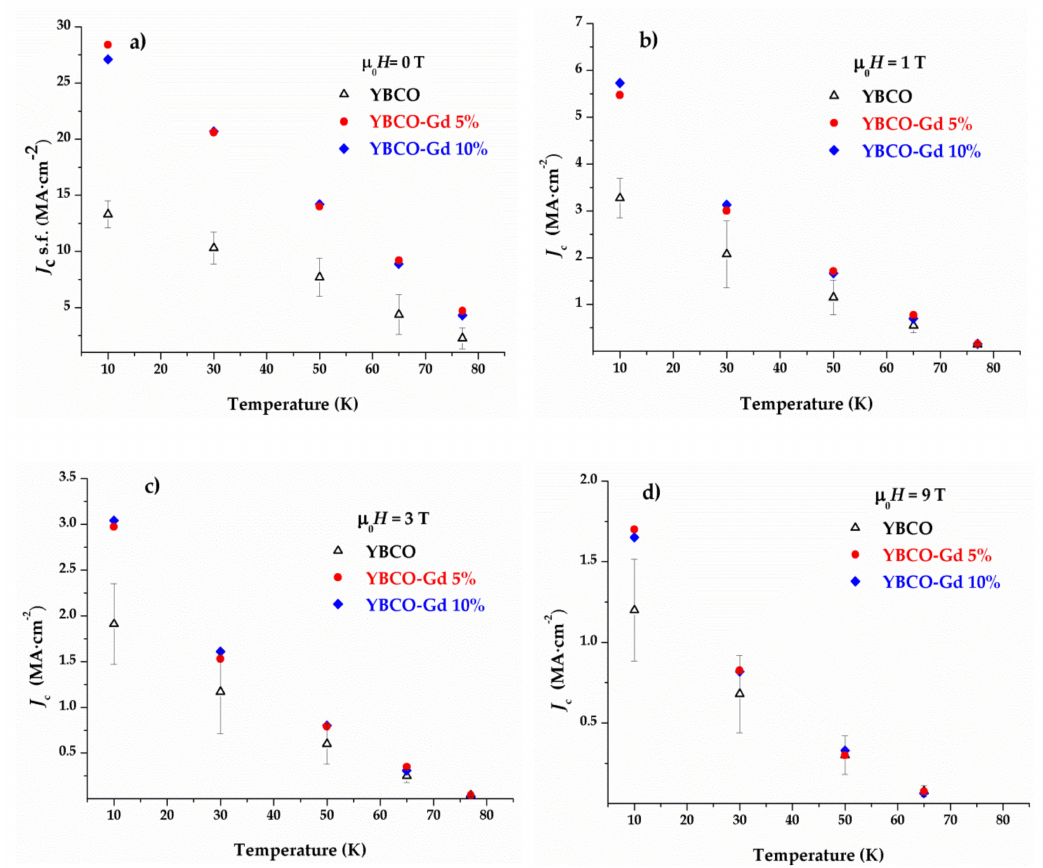
Figure 9. Critical current density ( J c ) in self-field condition (B = 0 T) ( a ), at 1 T ( b ), 3 T ( c ), and 9 T ( d )